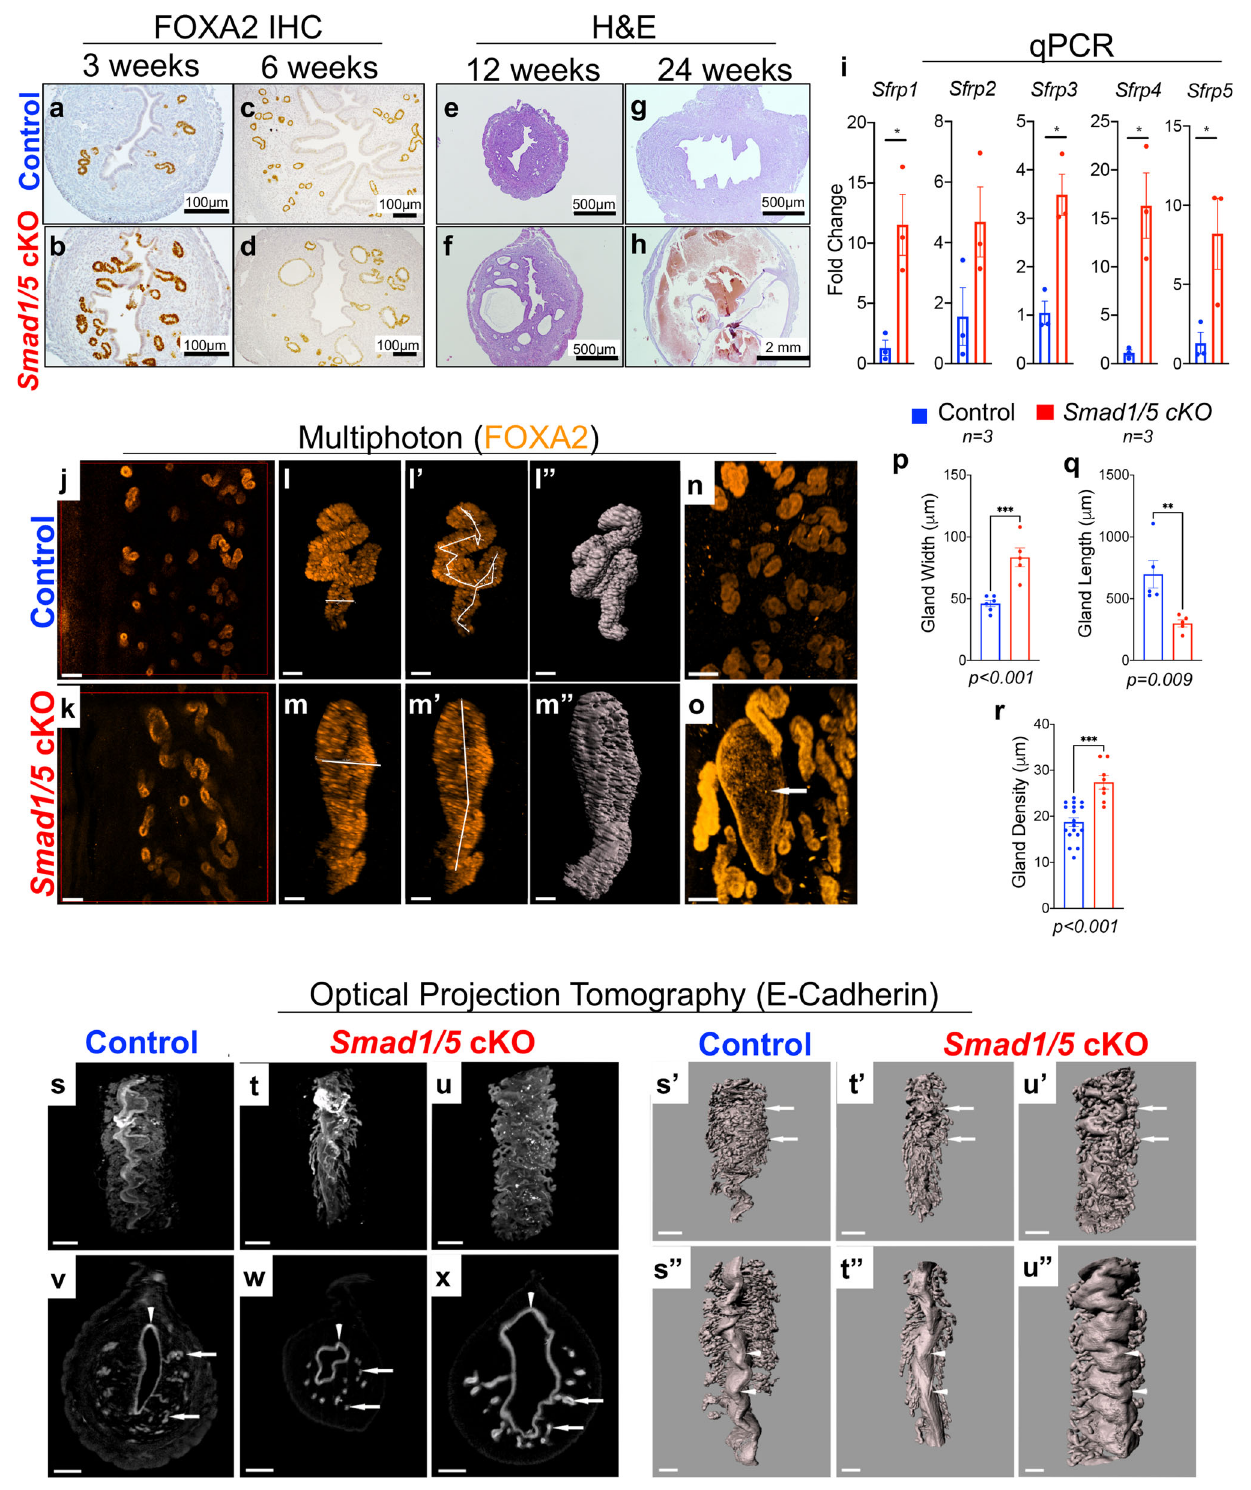
SMAD1/5 signaling is essential for uterine gland 3D mor- phology and WNT-signaling . Analysis of uterine morphology in control and Smad1/5 cKO mice throughout development iden- ti fi ed morphological defects in the uterine glands of the Smad1/5 cKO mice that worsened with age (Fig. 2). IHC of the glandular- speci fi c marker, FOXA2 24,25 , in the 3- and 6-week-old uterus indicated the presence of glands in both control and Smad1/5 cKO females (Fig. 2a – d). The glands enlarged and were observed